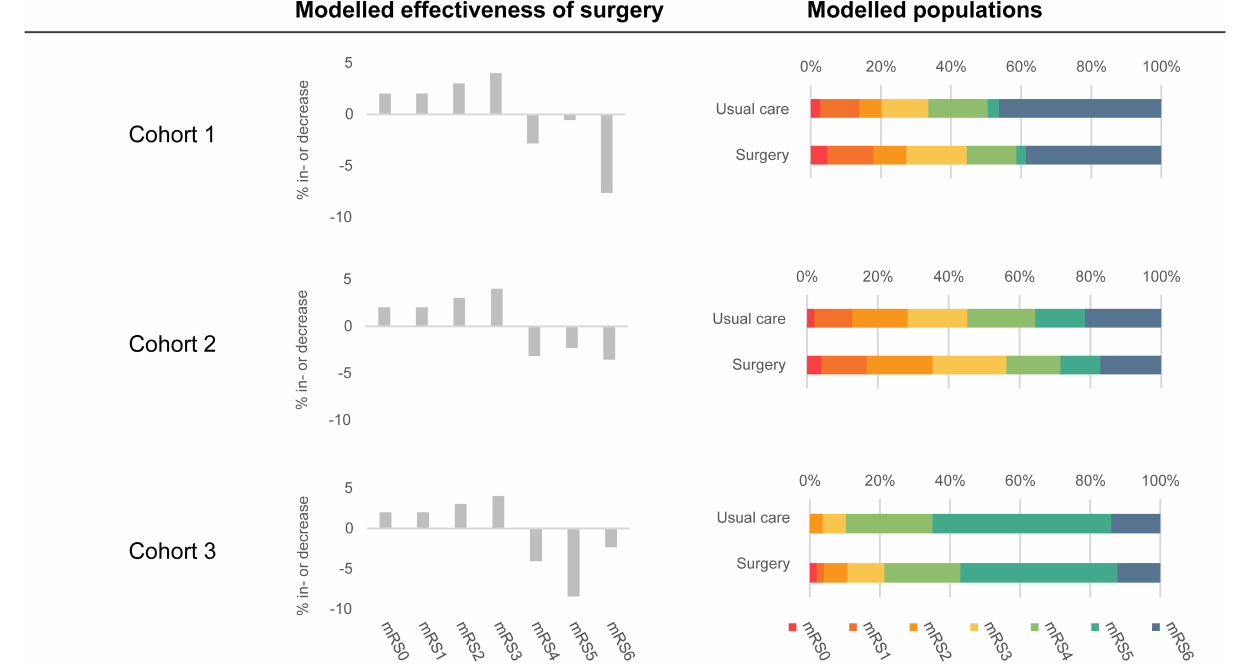
At least 1.5% (95%-CI: 0.8–2.5%; Cohort 1), 1.5% (95%-CI: 0.8– 2.5%; Cohort 2) or 1.1% (95%-CI: 0.6–1.7%; Cohort 3) of